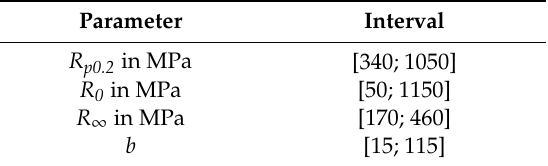
Table 5. Intervals of material model parameters variation.